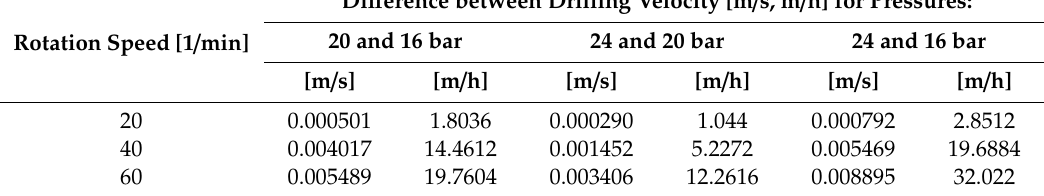
Table 2. Di ff erences between drilling velocity measured for various air pressures and drill rotation speeds of the 110 mm diameter drill bit, in the interval 72–90 m below ground level.